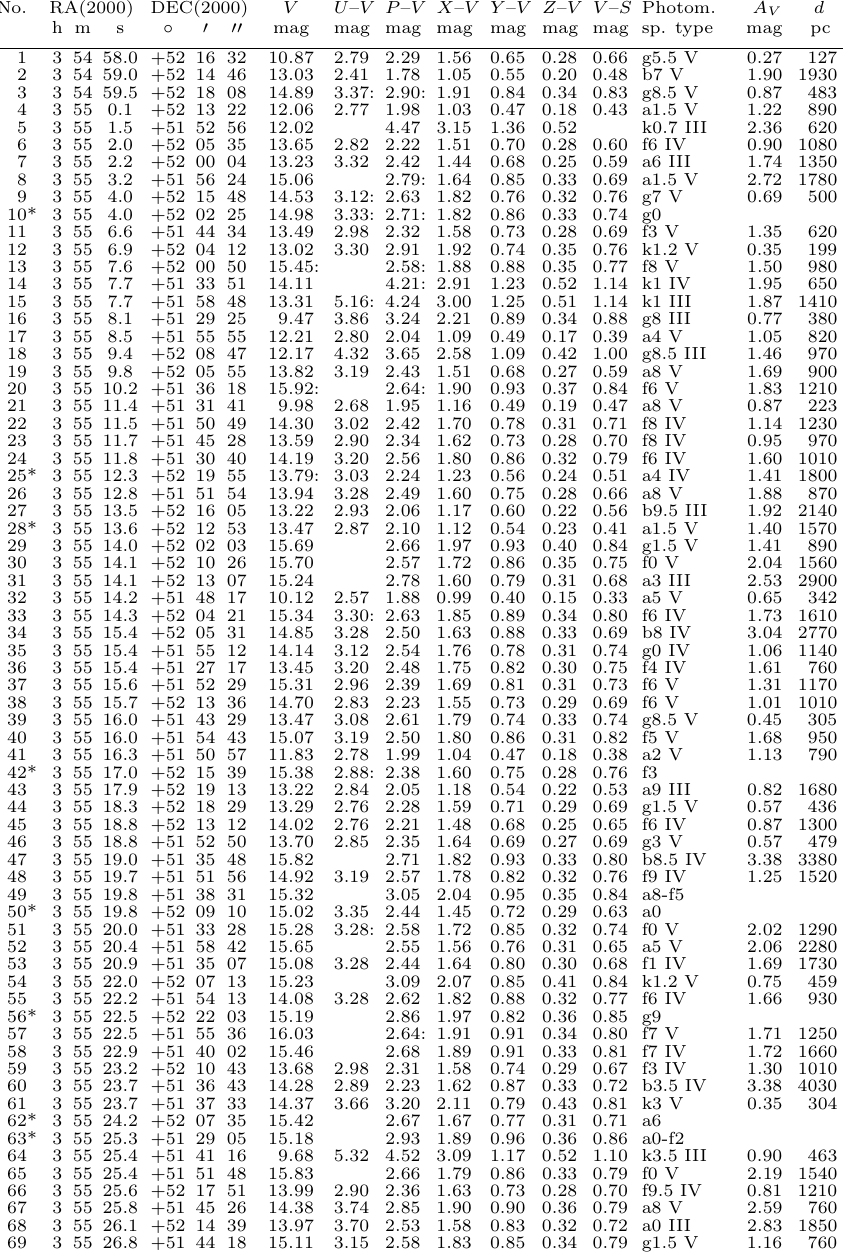
Table 3. Results of photometry, interstellar extinctions and distances for stars in the vicinity of King 7. No. RA(2000)